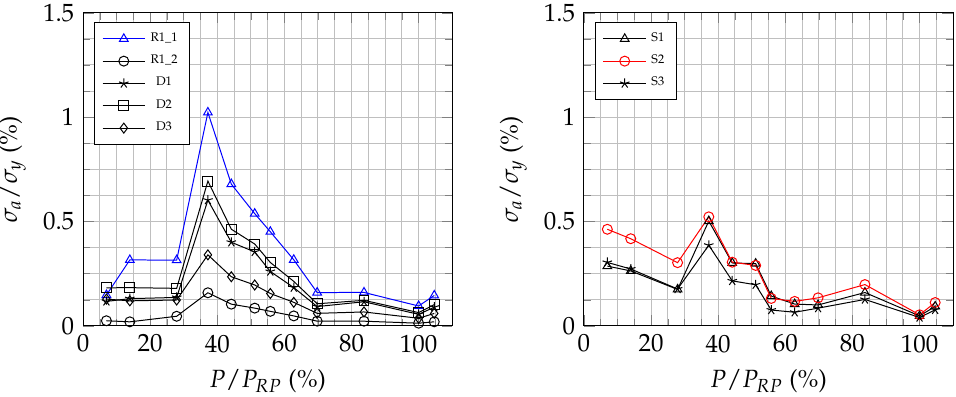
Figure 26. Dynamic stresses at strain gauge positions close to the runner hub for PS ( left ) and SS ( right ).